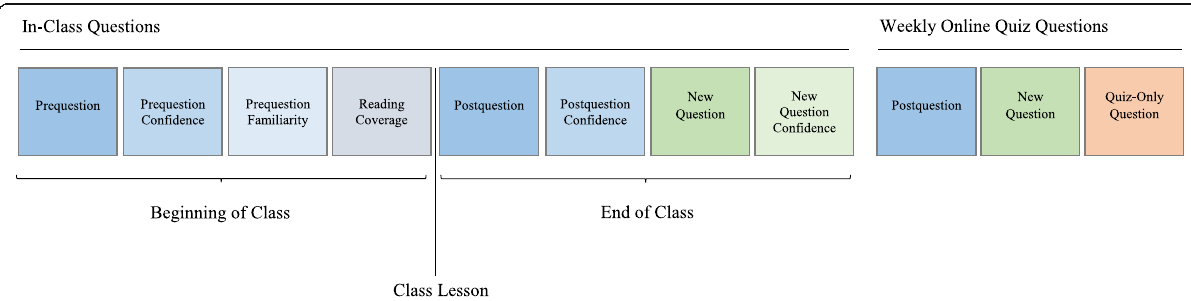
Fig. 2 In-class questions and weekly quiz questions. At the beginning of each class meeting, students answered one prequestion over the upcoming lesson, followed by their confidence in their answer, familiarity with the material in the question, and how much of the reading assignment they completed prior to class. At the end of the class meeting, students answered the same question as before and rated their confidence again, and also answered a new, never-before-seen question from the same lesson and rated their confidence. After students ’ confidence ratings on the end-of-class questions, the instructor provided the answers. On the weekly online quiz, students answered the same postquestion and new question, along with a never-before-seen (i.e., quiz-only) question from the same lesson, and received correct answer